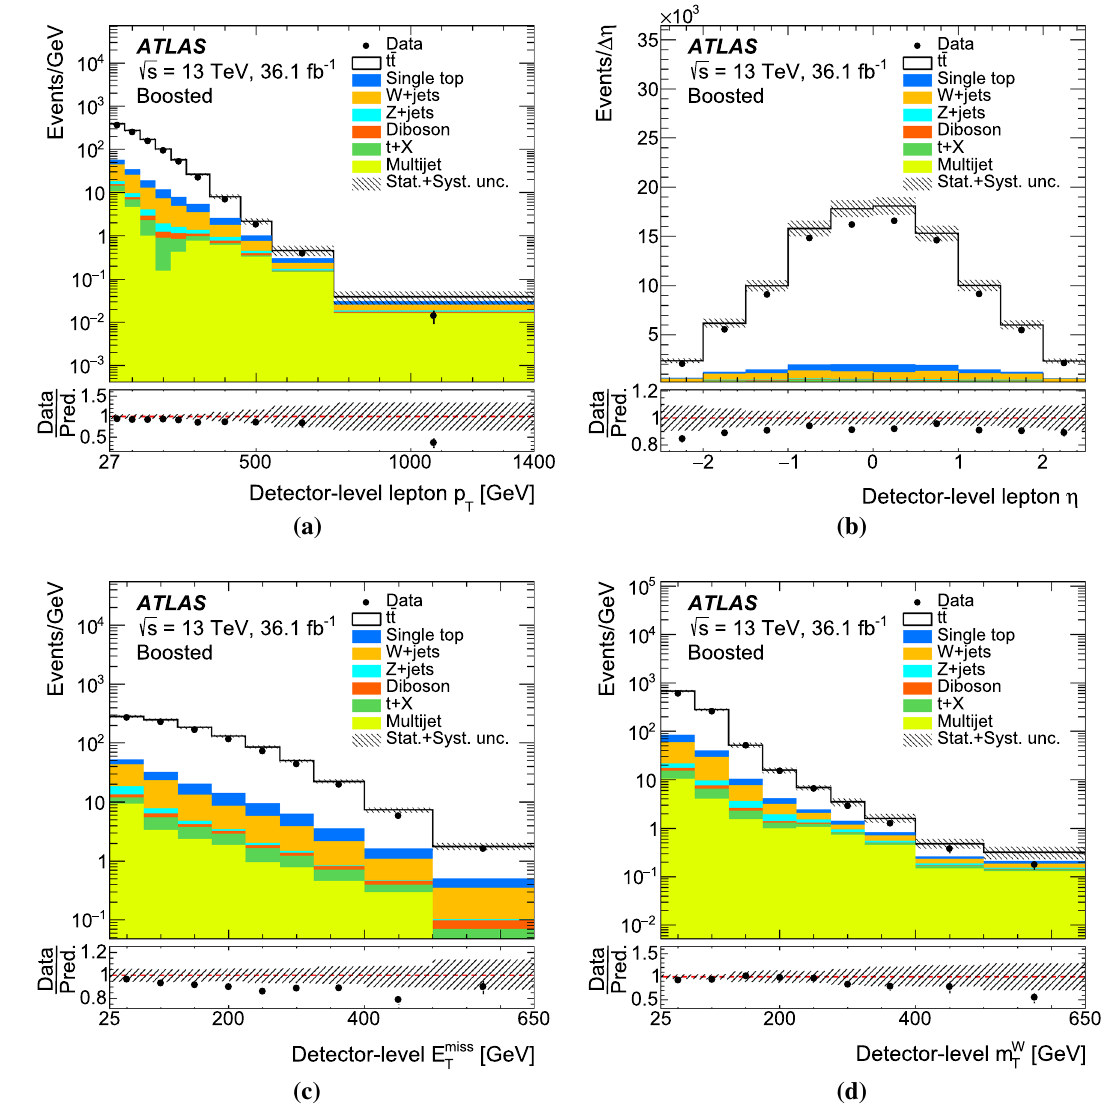
Fig. 4 Kinematic distributions in the (cid:3) + jets channel in the boosted tistical and systematic uncertainties (described in Sect. 9) in the total prediction, excluding systematic uncertainties related to the modelling topology at detector-level: a lepton p T and b pseudorapidity, c missing of the t ¯ t events. Underflow and overflow events, if any, are included in transversemomentum E miss and d transversemassofthe W boson.Data T the first and last bins. The lower panel shows the ratio of the data to the distributions are compared with predictions using Powheg + Pythia8 total as the t ¯ t signal model. The hatched area represents the combined sta-